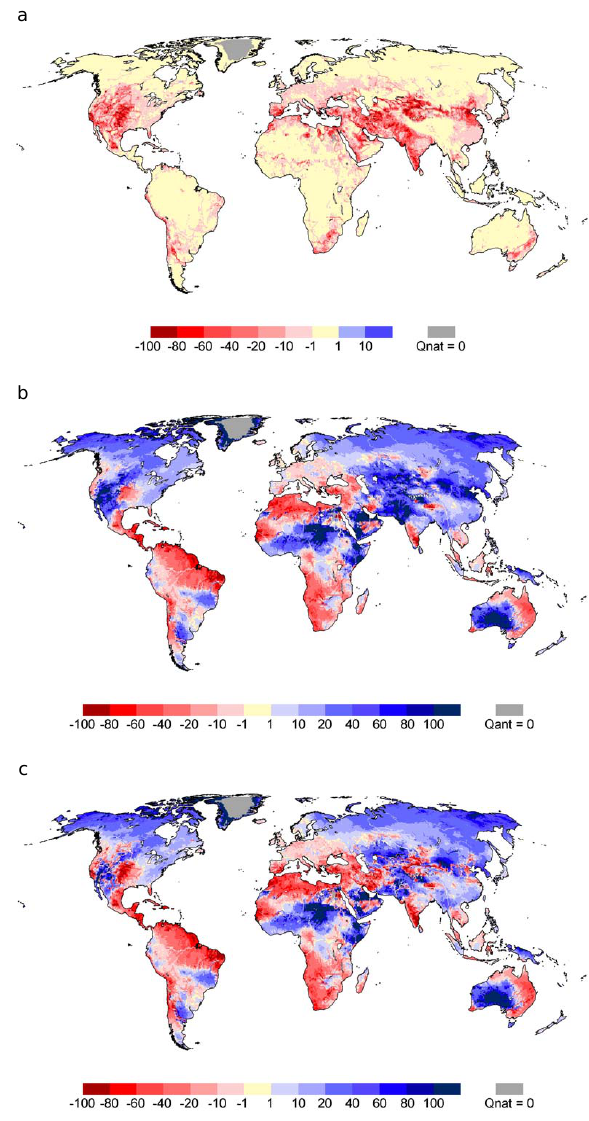
Fig. 3. Comparison of the impact of climate change to the impact of dams and water withdrawals with respect to long-term average annual river discharge ( I LTA ) . Impact of dams and withdrawals on naturalized discharge (ANT – NAT, in % of NAT) (a) , impact of climate change on anthropogenically altered discharge (CC-ANT – ANT, in % of ANT) (b) , combined impact of climate change, dams and water withdrawals (CC-ANT – NAT, in % of NAT) (c) . Dams and withdrawals in the year 2002, climate change between 1961–1990 and 2041–2070 according to the emissions scenario A2 as implemented by the global climate model